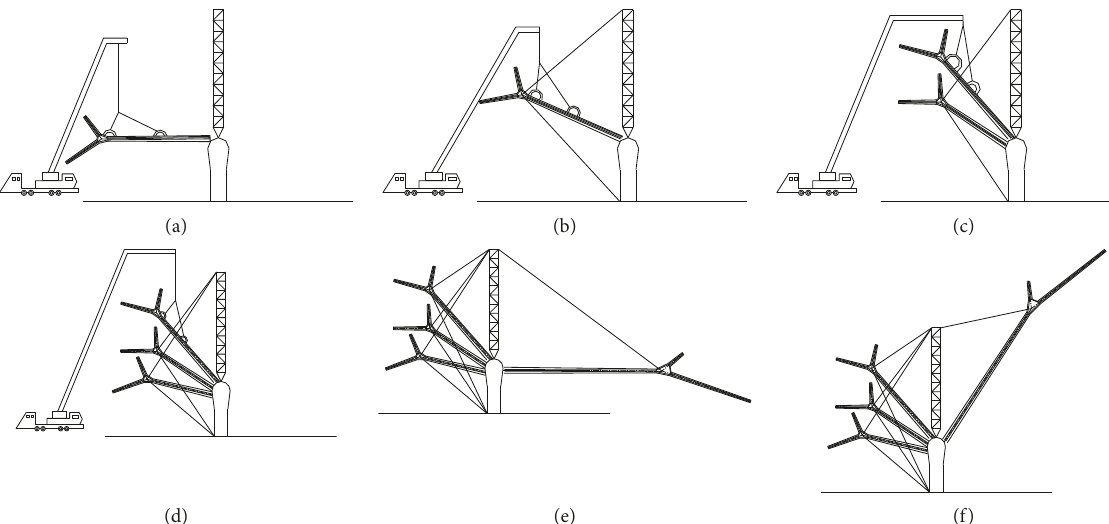
Figure 4: Self-balancing elevating scheme. (a) lifting the first small branch; (b) lifting the first small branch to design position and anchoring cables; (c) installing the second small branch; (d) installing the third small branch; (e) assembling the big branch horizontally; (f) lifting the big branch to design position.